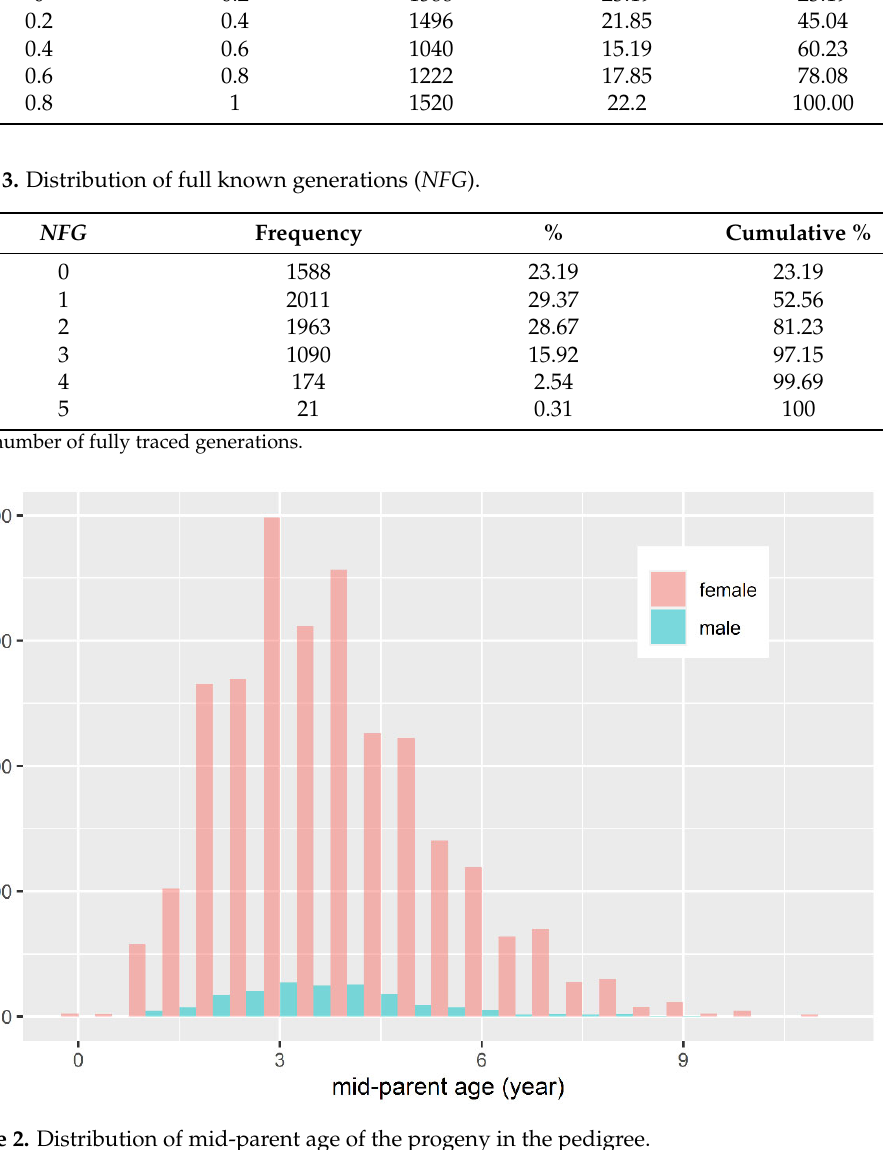
Figure 2. Distribution of mid ‐ parent age of the progeny in the pedigree.